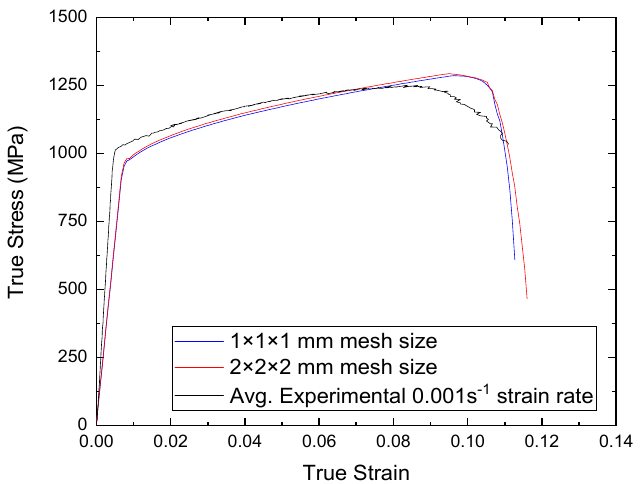
Figure A7. True stress–strain plot comparison for 0.001 s − 1 strain rate for average experimental and numerical simulation using average mesh sizes of 1 × 1 × 1 and 2 × 2 × 2 mm.